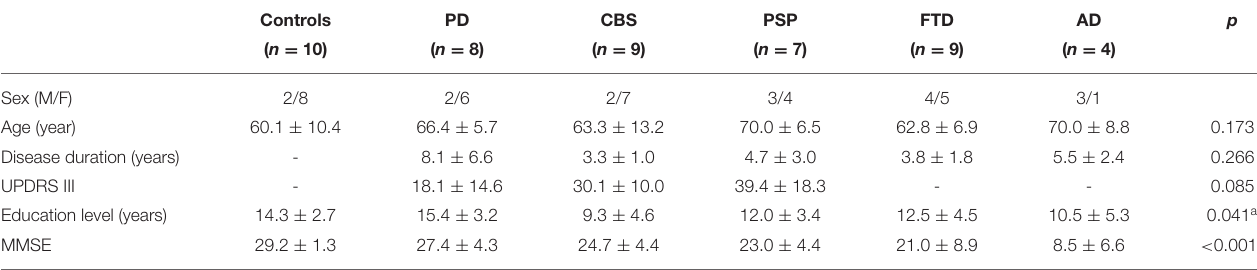
TABLE 1 | Basic characteristics of the study participants. Controls